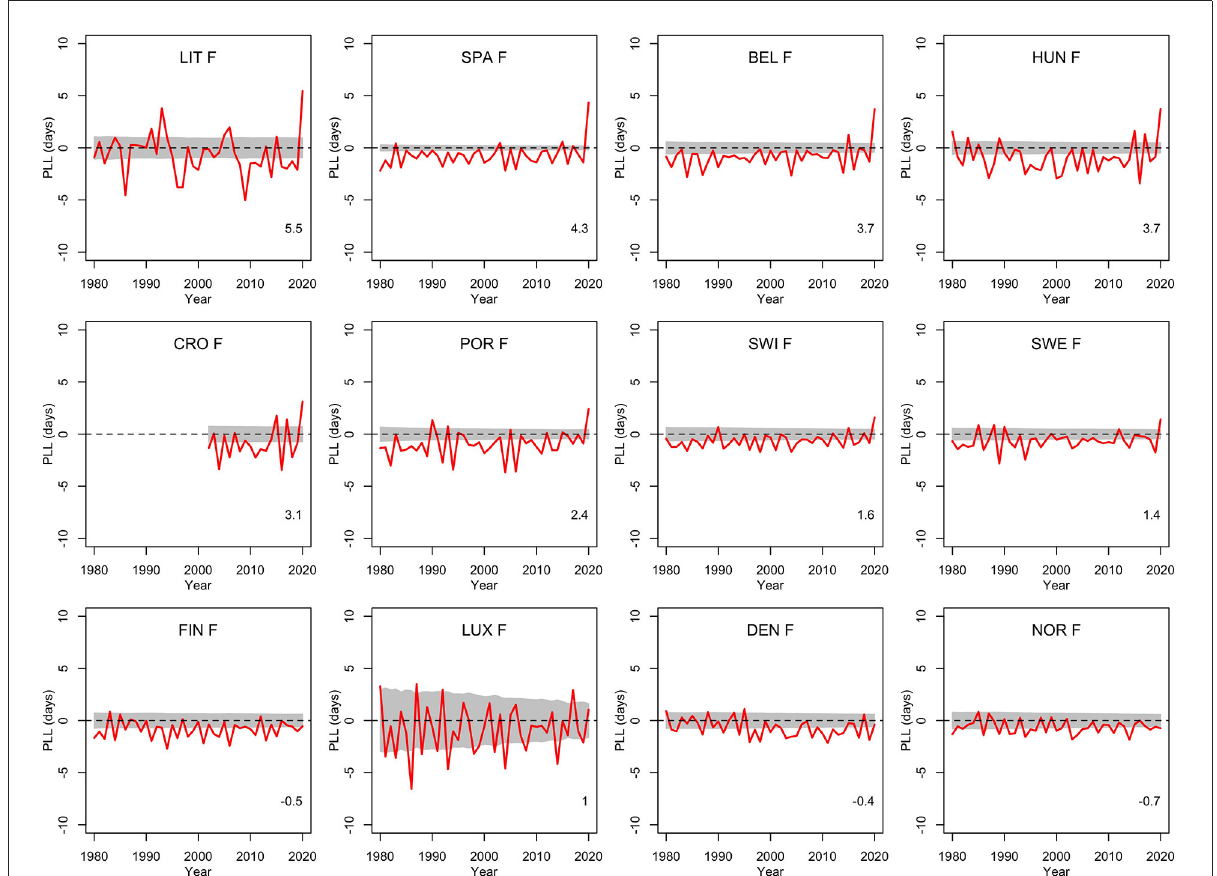
FIGURE2 Population life loss ( PLL y ) in years y between 1980 and 2020 for women (F) of 12 European countries, together with 95% prediction intervals calculated under the null hypothesis of a similar mortality as the year before. At the bottom, population life loss in 2020 ( PLL 2020 , expressed in days) is